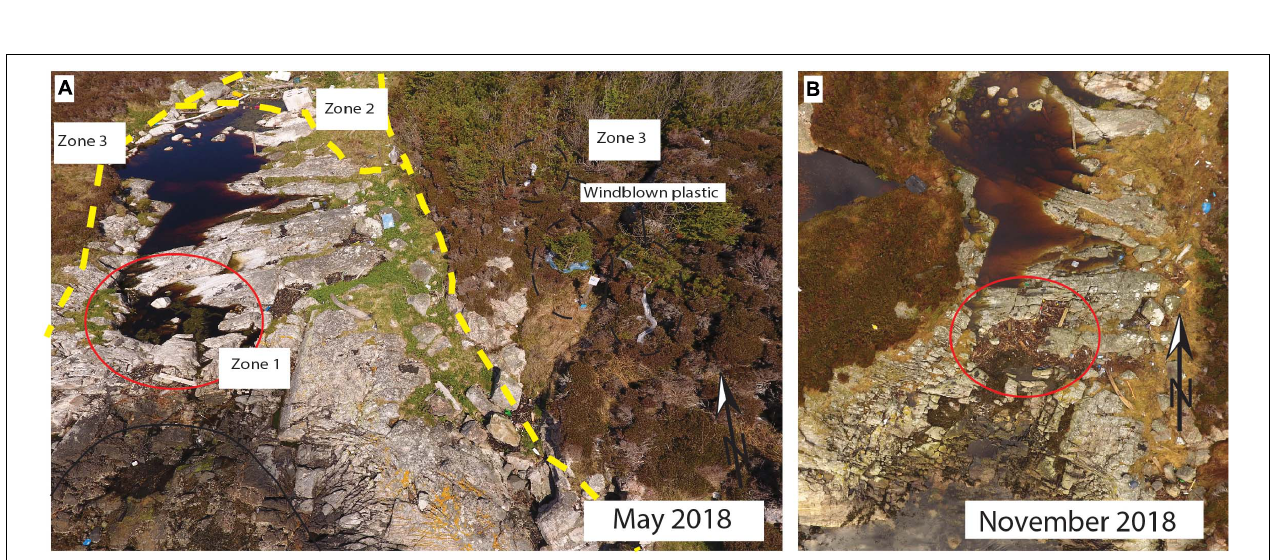
FIGURE 5 | Zone 1 Drone photo of the cove area representative of Zone 1. (A) Photo taken in May 2018, note the clear area (red circle) (B) drone photo acquired in November (winter) with a substantial increase in deposited waste. No cleaning had been performed in the area.